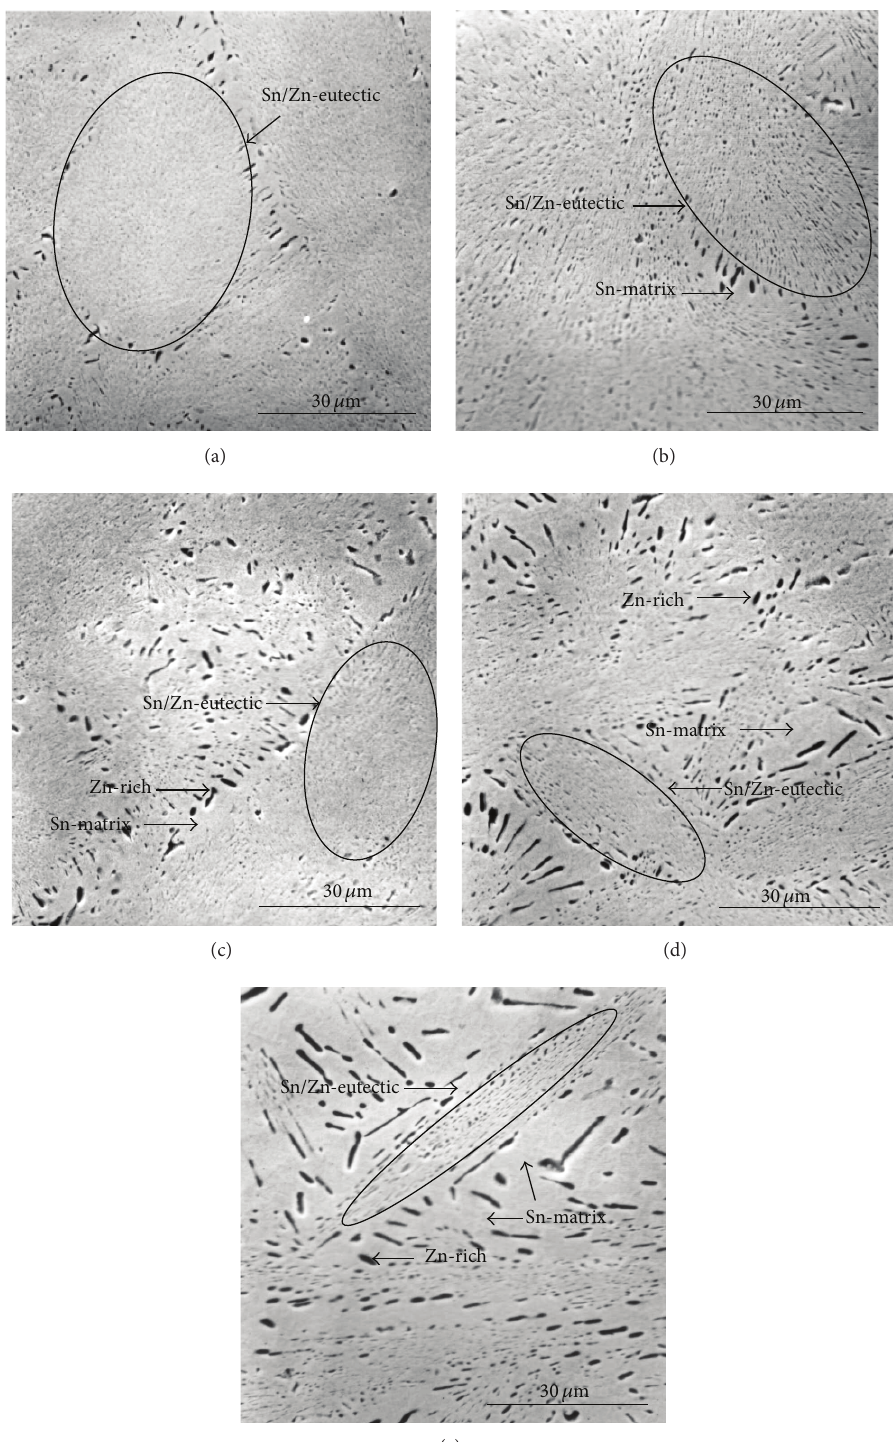
Figure4:TheSEMmicrographsofthe(a)Sn-9Zn,(b)Sn-9Zn-0.25Ga,(c)Sn-9Zn-0.50Ga,(d)Sn-9Zn-0.75Ga,and(e)Sn-9Zn-1.00Gasolder